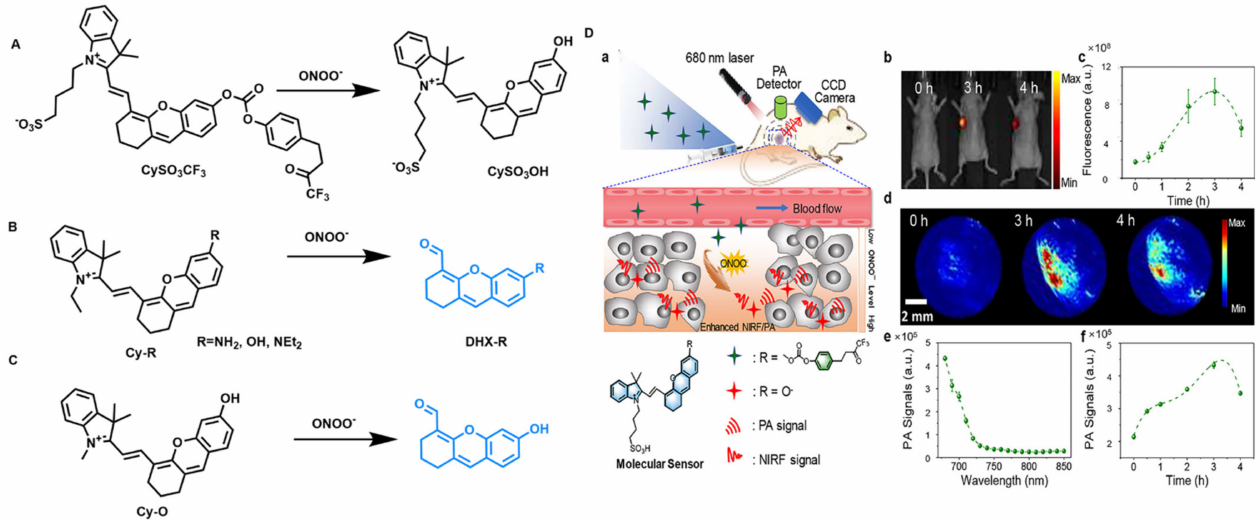
Figure 9. The fluorescence probe’s response mechanisms and chemical composition for ONOO − for ( A ) CySO 3 CF 3 , ( B ) Cy-R, and ( C ) Cy-O. ( D ) In vivo NIRF and PA imaging of ONOO − us- ing CySO 3 CF 3 . ( a ) Illustration of the mechanism for NIRF and PA imaging of ONOO − in tu- mor using CySO 3 CF 3 . CySO 3 CF 3 first accumulates into tumor and then is activated by ONOO − through cascade oxidation-elimination reactions, eventually resulting in enhanced NIRF/PA